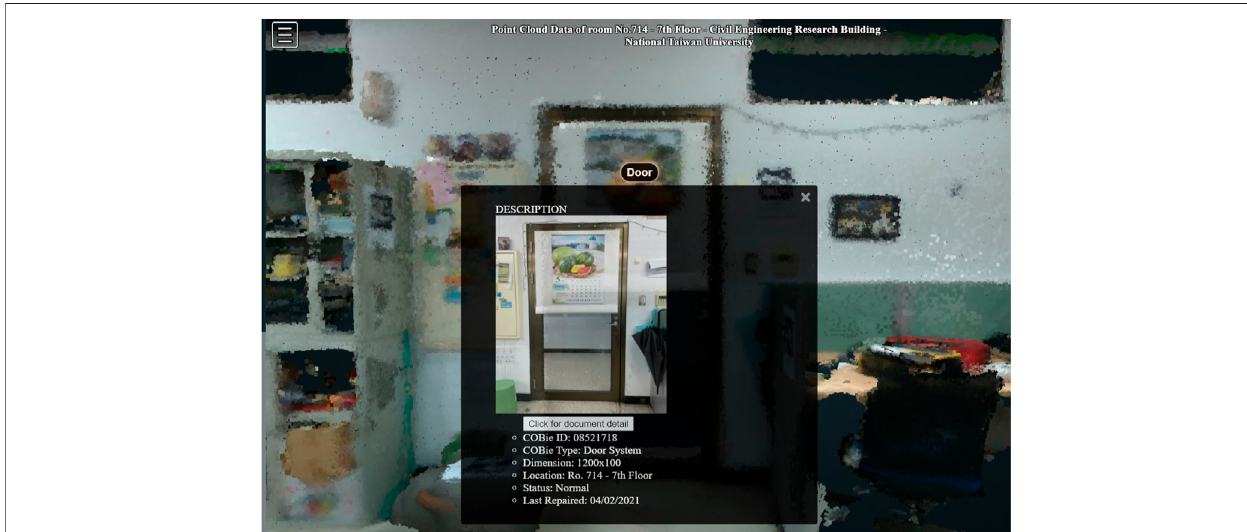
FIGURE 11 | “ Annotations ” feature of AIM prototype.